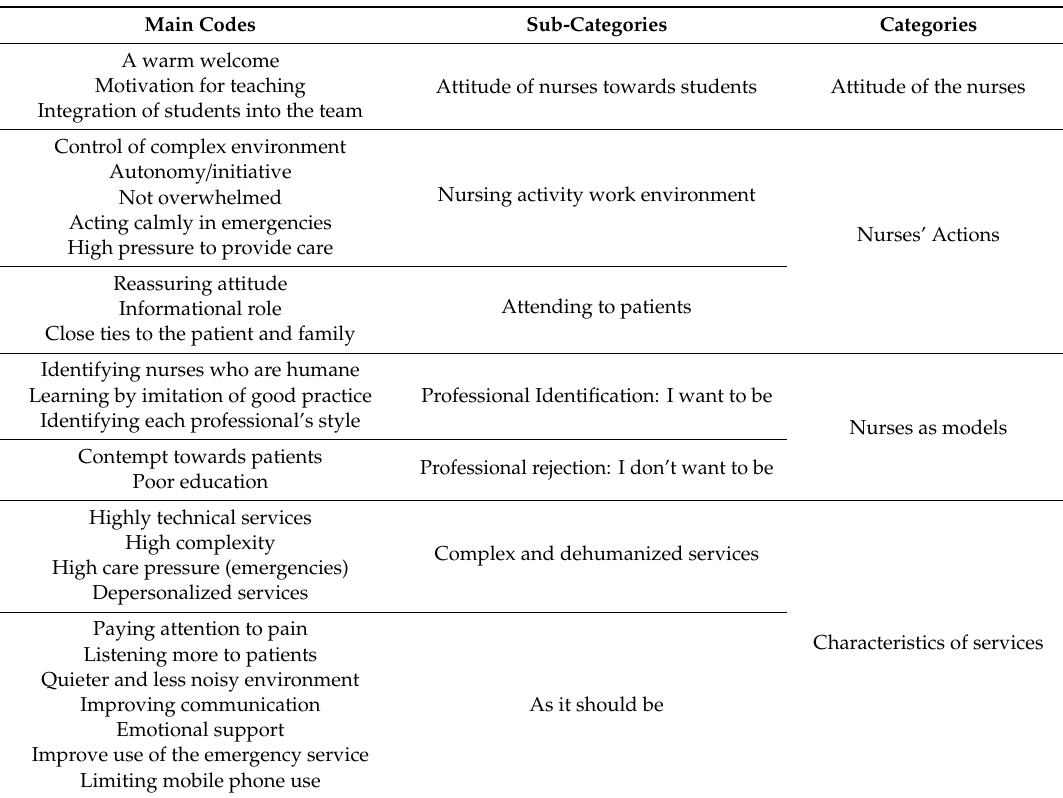
Table 3. Main categories, sub-categories and codes about the theme “identify with nurses who dominate their environment and are close to the patient in complex and dehumanized